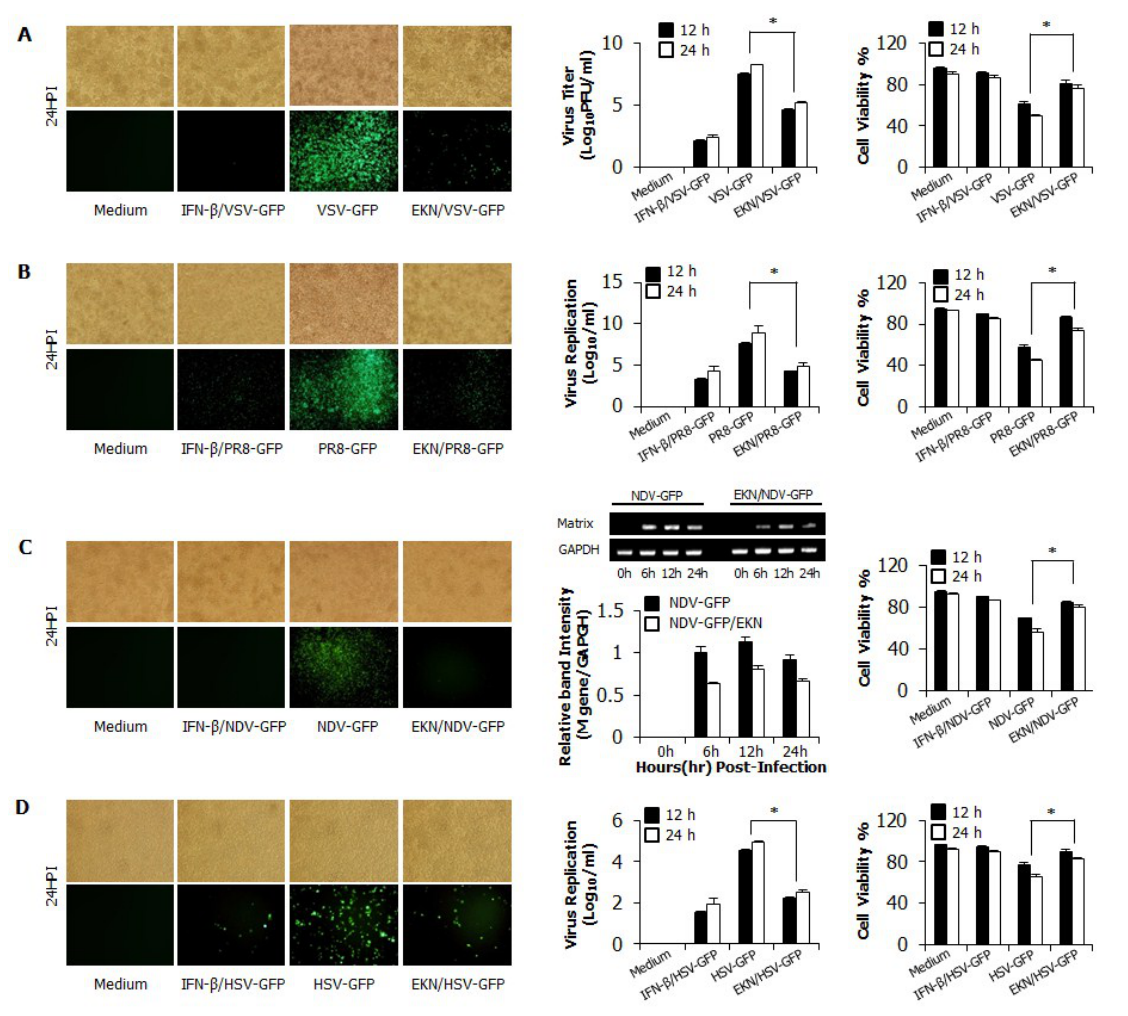
Figure 1 . Antiviral activities of Epimedium koreanum Nakai in RAW264.7 cells. RAW264.7 cells treated with media alone, 1.0 µg/mL Epimedium koreanum Nakai (EKN), or 1000 unit/mL recombinant mouse IFN-β, 12 h prior to infection with ( A ) VSV-GFP; or ( B ) PR8-GFP; or ( C ) NDV-GFP; or ( D ) HSV-GFP at an MOI of 1.0. Images